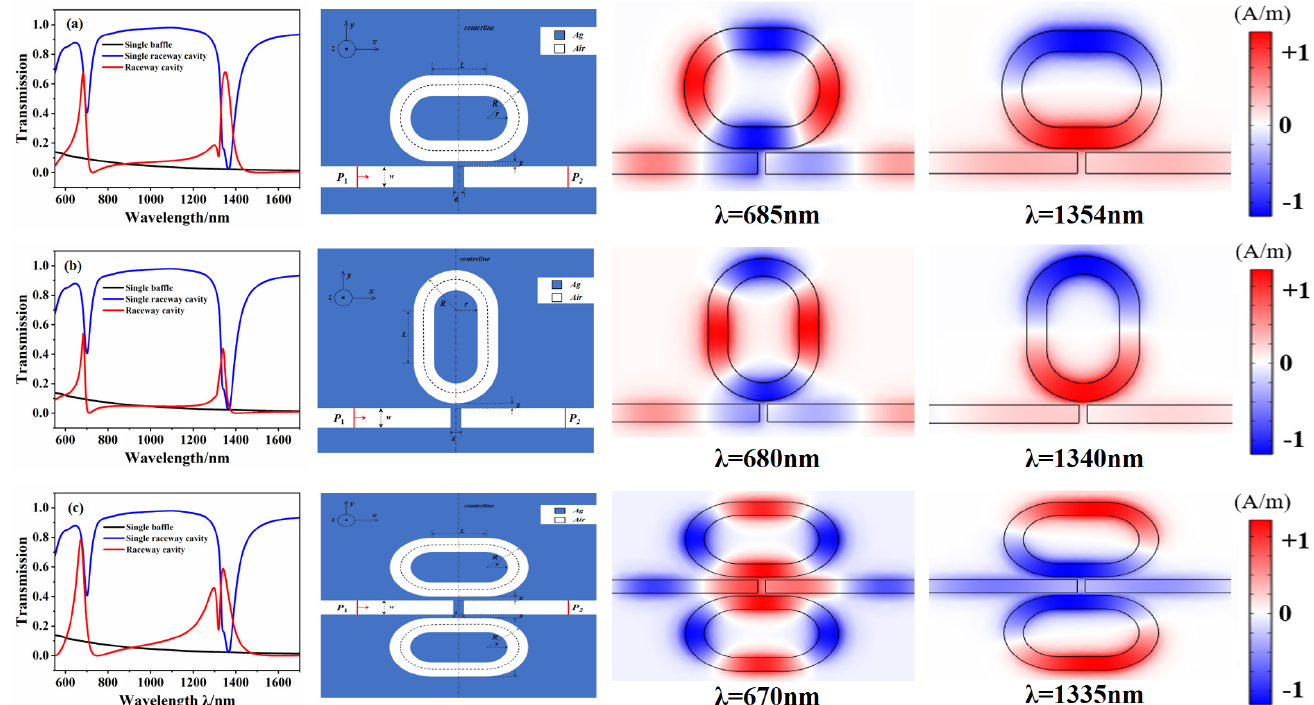
Figure 3. Transmission spectrum, structure diagram, and the Hz field distribution diagram of resonance point of RTRC under different placement methods. ( a ) Horizontal placement. ( b ) Vertical placement. ( c ) Symmetrical placement.